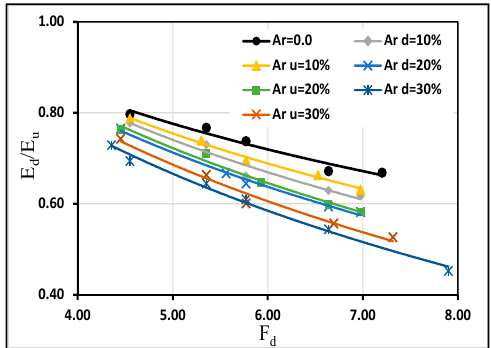
Figure 12. Culvert efficiency for different Ar.